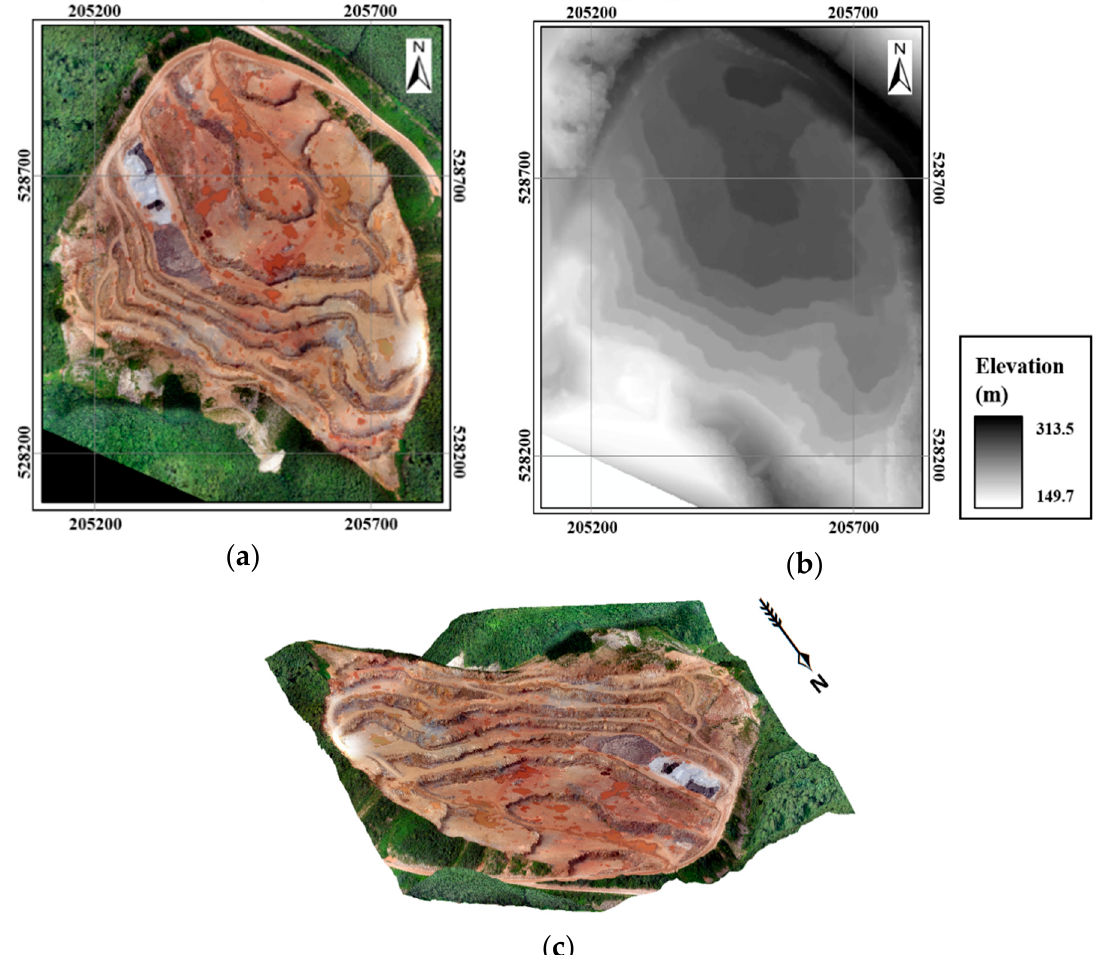
Figure 5. Topographic information of the study area: ( a ) the orthographic image was obtained via unmanned aerial surveying; ( b ) a digital surface map of the open-pit mine; and ( c ) a 3D visualization of the study area using the orthographic image. The reference grid is in meters and the origin of the local Transverse Mercator coordinate system is 38°00 ′ 00 ′′ N, 129°00 ′ 00 ′′ E (map datum: GRS1980).